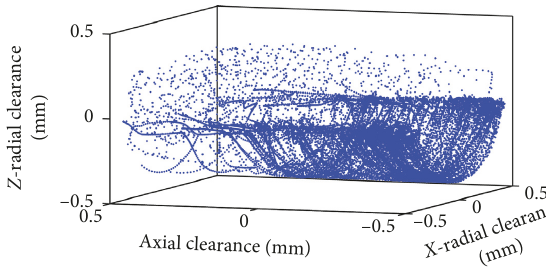
Figure 20: Point distribution of middle joint in simulation with c